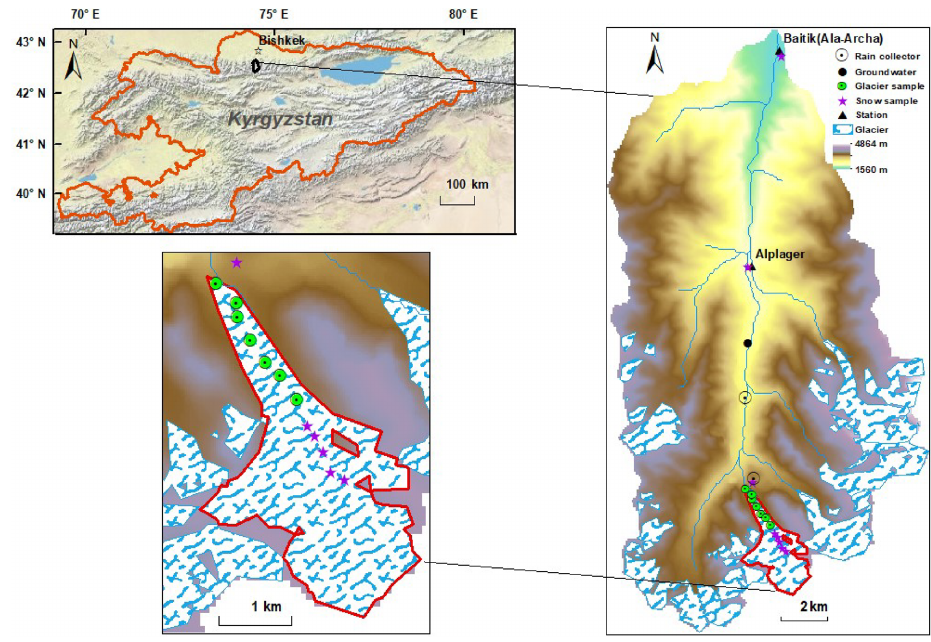
Figure 1. Study area of the Ala-Archa basin (derived from the World Topographic Map by © ESRI) and the Golubin glacier, including the locations of the water sampling